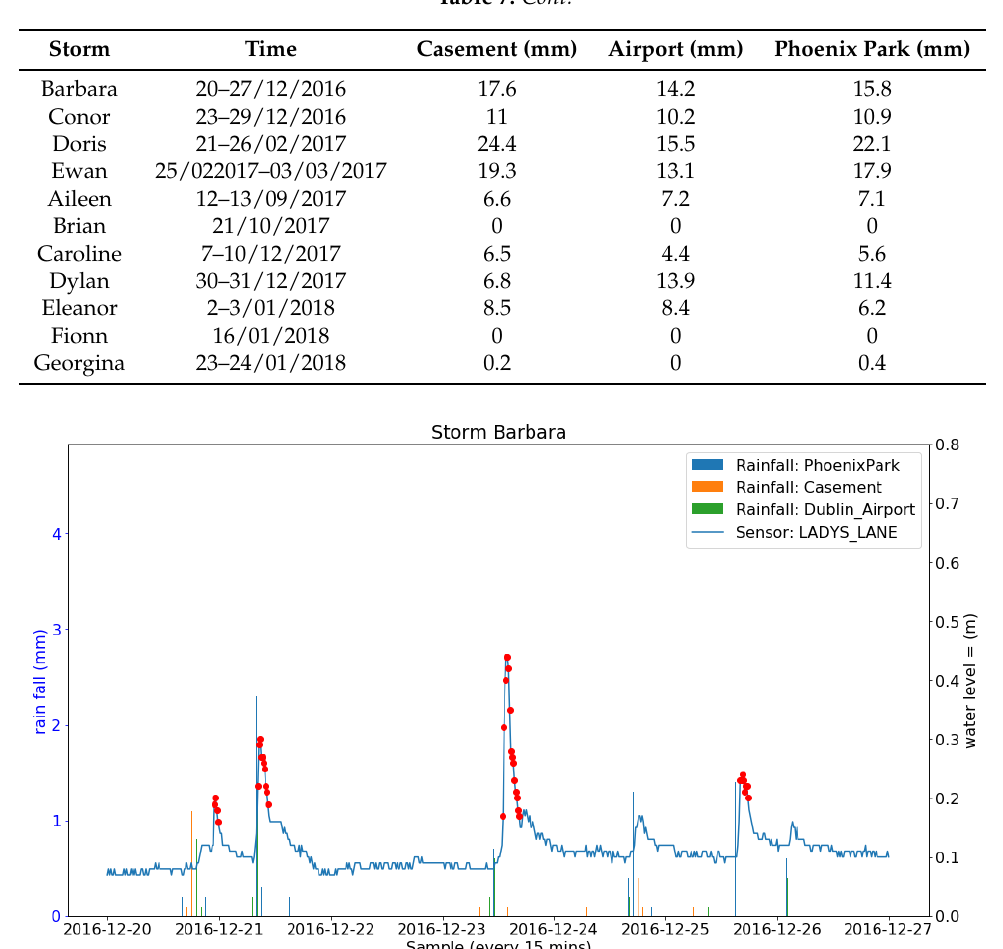
Figure 13. Rainfall from three Met Eireann weather stations and the water level sensor measurements along with the anomalies detected and the four events constructed during the Storm Barbara.